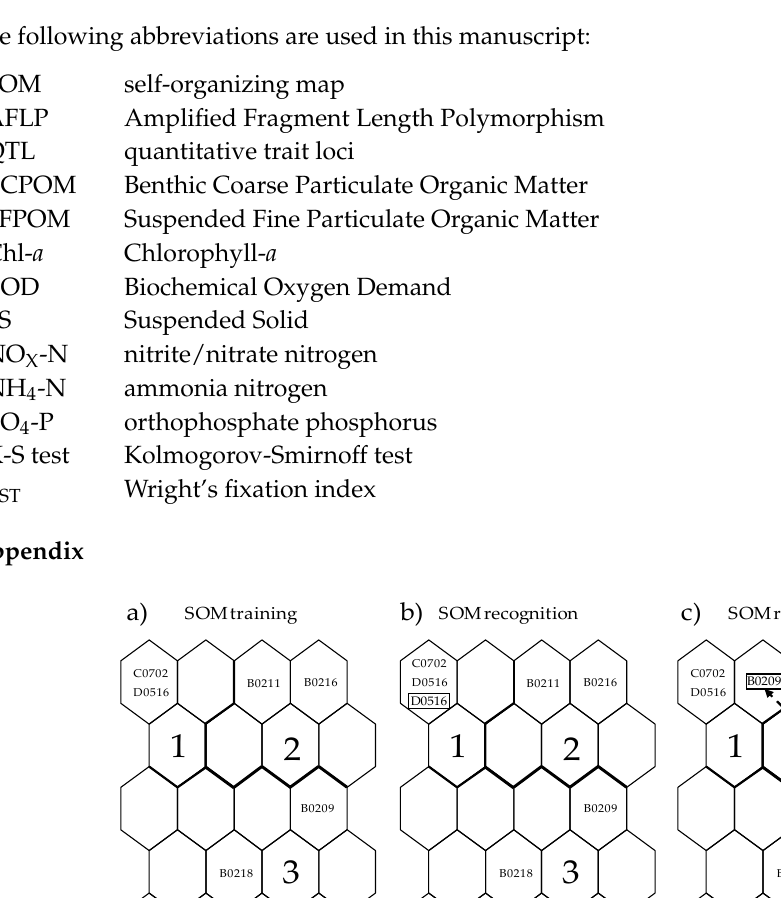
Figure A2. U-matrix based on SOM according to individual loci compositions in Hydropsyche albicephala ( a ); Stenopsyche marmorata ( b ); and Hydropsyche orientals ( c ). Color bars in the U-matrix indicate the mean Euclidean distance between the weights of nodes surrounding the U-matrix on the map.